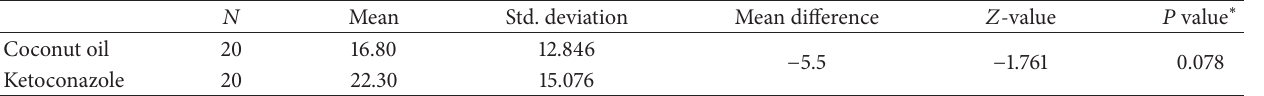
Table 3: Comparison of zone of inhibition between coconut oil and ketoconazole.